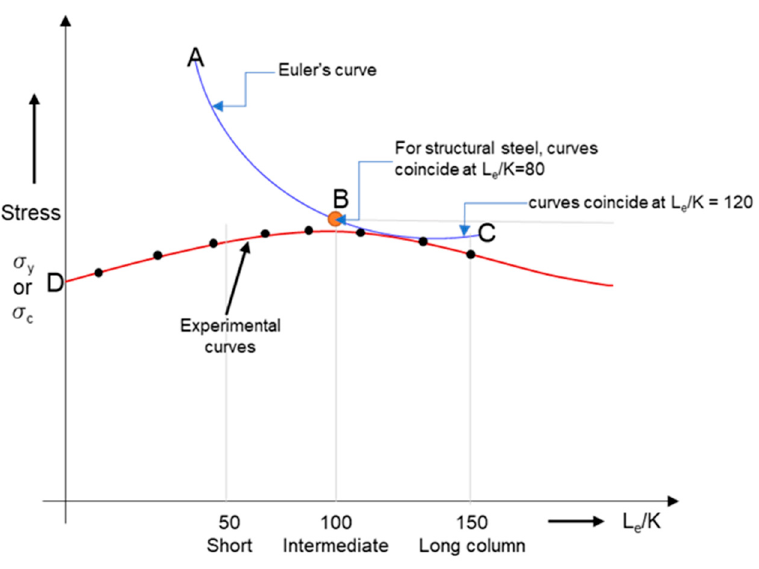
Figure 5. Slenderness ratio vs. buckling stress [5].